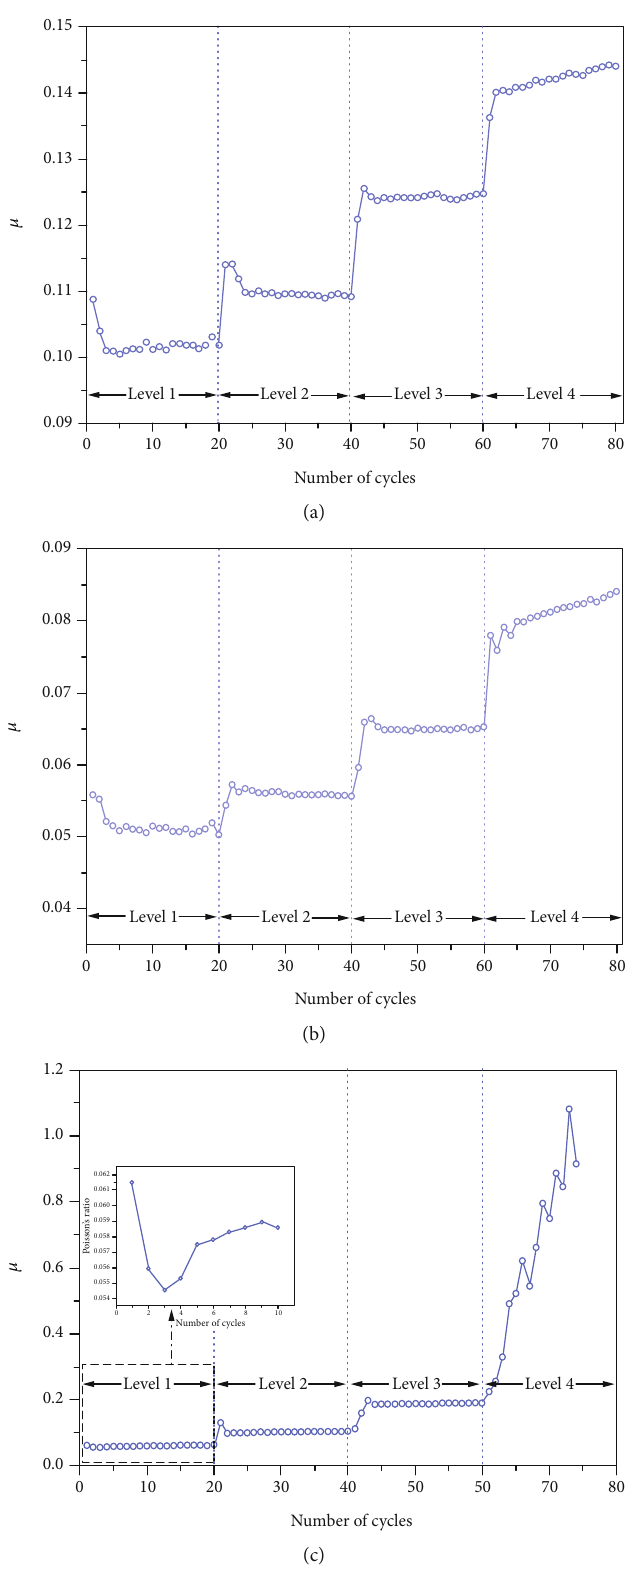
Figure 6: Evolution of Poisson ’ s ratio with the number of cycles under di ff erent frequencies: (a) 0.1Hz; (b) 0.2 Hz; (c)